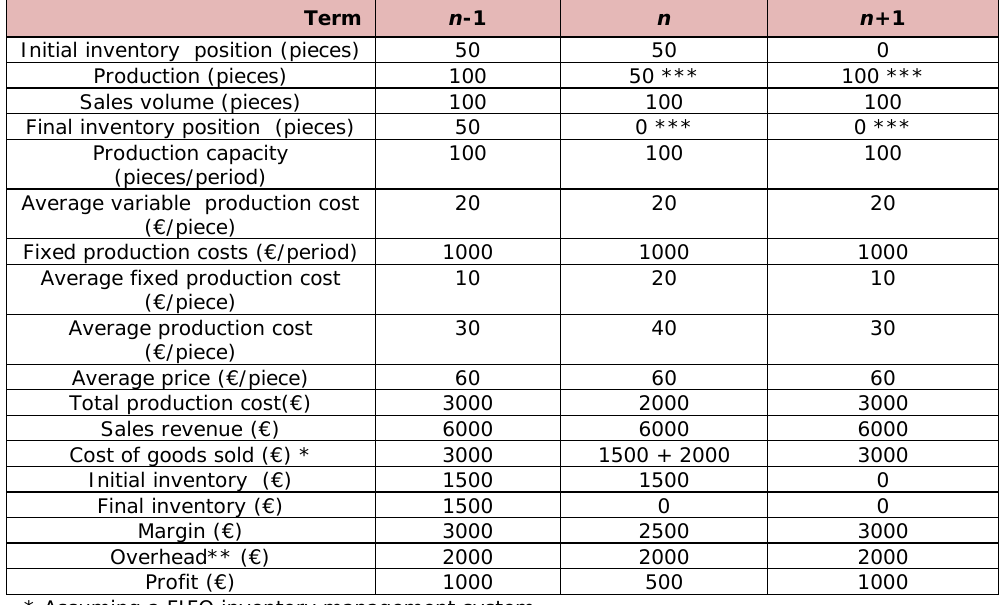
Table 1. “Calculation of the production cost after and before production adjusted to demand”. Based on Olivella